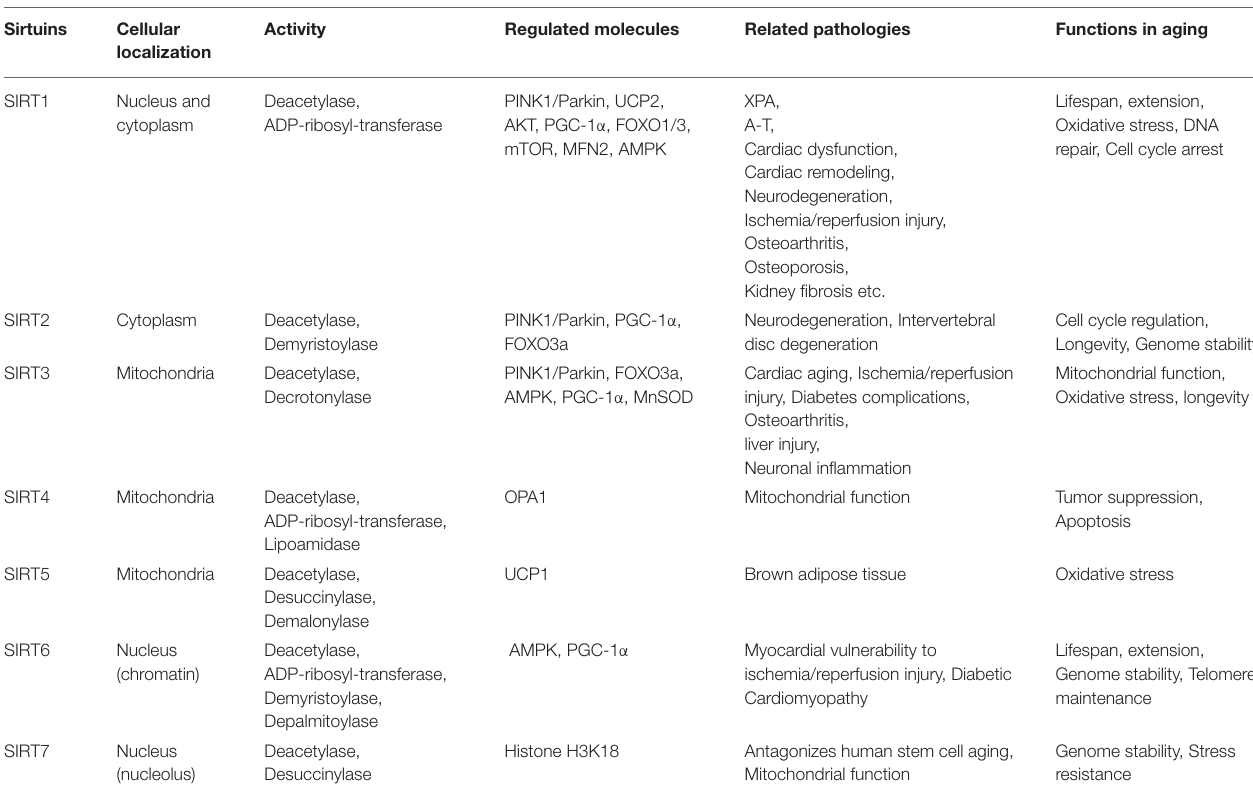
TABLE 1 | Properties and functions of SIRT famliy related with aging. Sirtuins Related pathologies Functions in